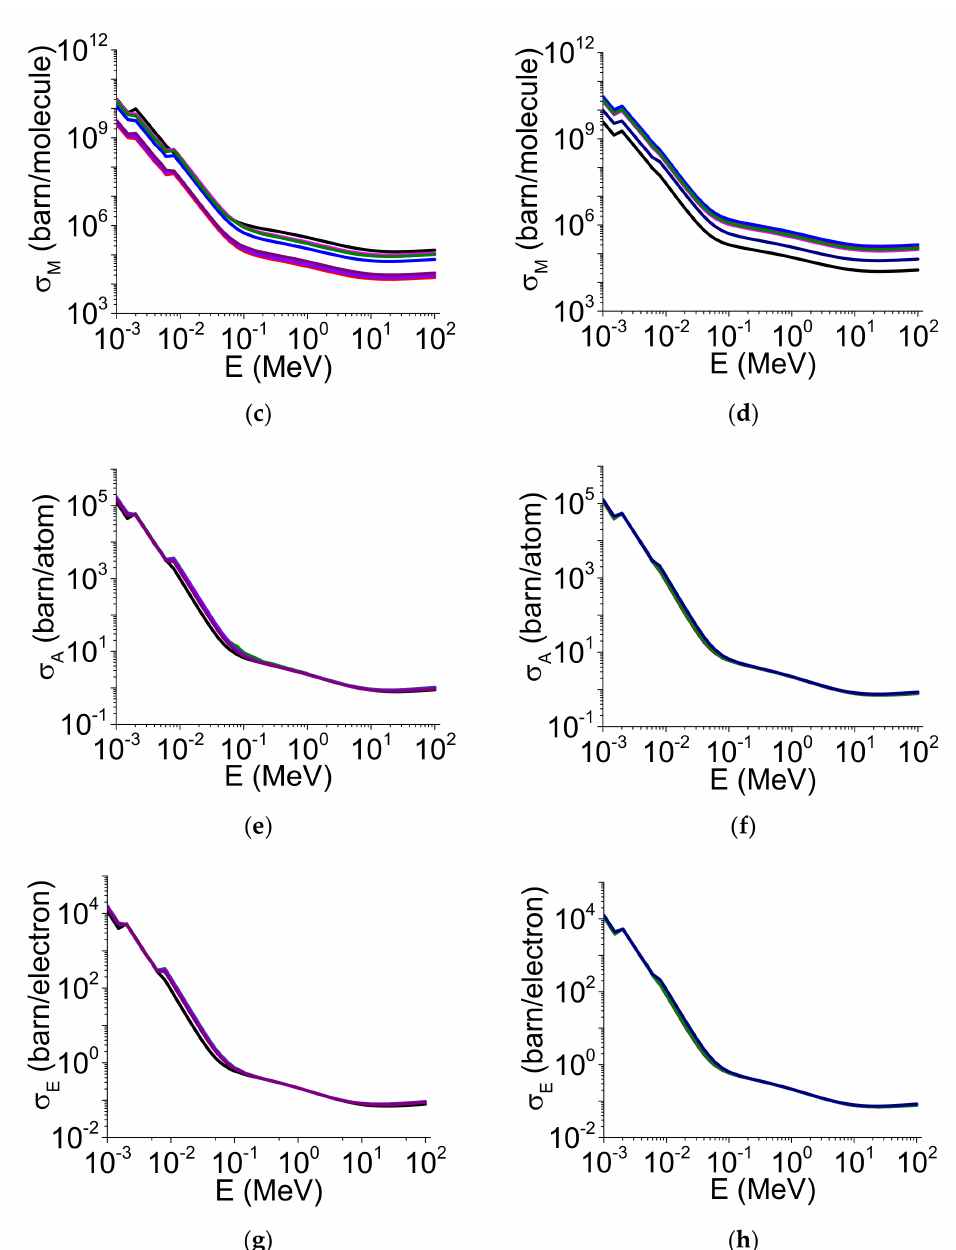
Figure 2. Mass attenuation coefficient ( µ / ρ ), molecular cross-section ( σ M ), atomic cross-section ( σ A ), and electronic cross-section ( σ E ) variation as a function of the photon energy (E) (1 keV–100 MeV)